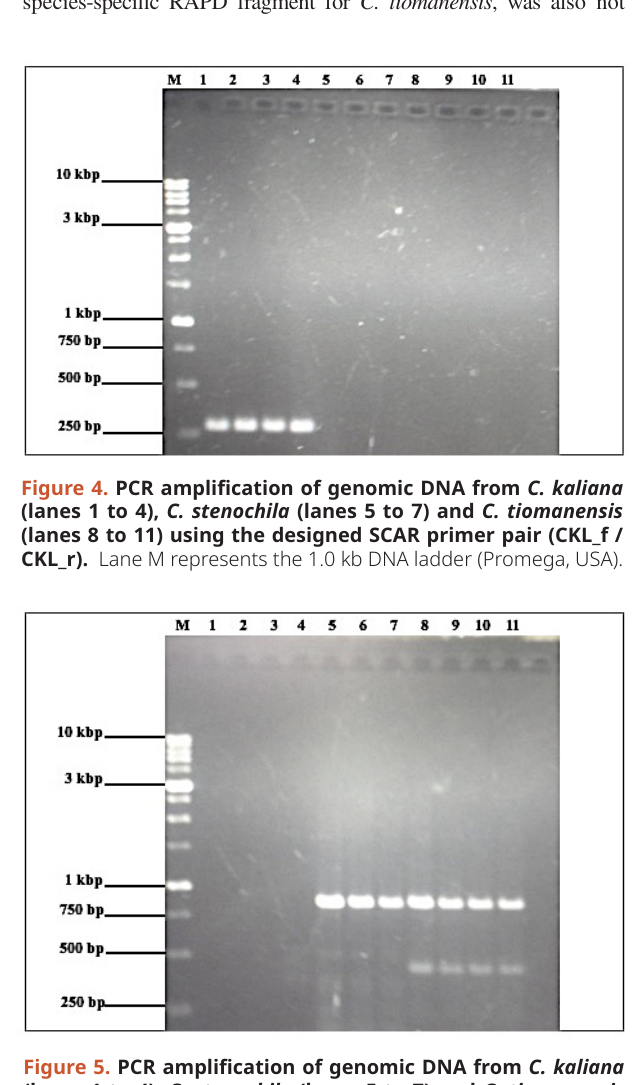
Figure 6. PCR amplification of genomic DNA from C. kaliana (lanes 1 to 4), C. stenochila (lanes 5 to 7) and C. tiomanensis (lanes 8 to 11) using the designed SCAR primer pair (CTI_f / CTI_r). Lane M represents the 1.0 kb DNA ladder (Promega,